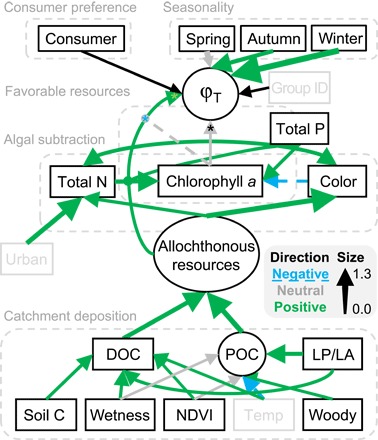
Modeled network of factors influencing terrestrial resource use (ϕT) by aquatic consumers across 147 lakes.Arrows point at modeled variables, with mean effects of one variable on another proportional to standardized effect size (see legend). Lines ending in circles are interactions. The asterisk symbol (*) indicates random variation among consumers, with colors showing direction of significant effects. Black lines are intercepts with no “effect direction,” ellipses are unobserved (that is, latent) variables, and gray boxes are covariates included to explain the connections between modeled variables and predictors of interest better. Five mechanisms explaining variation in ϕT are associated with broken boxes. NDVI, vegetation density; temp, mean monthly temperature of warmest quarter; woody, area of woody vegetation in catchment per meter shoreline; LP/LA, ratio of lake perimeter to lake area; group ID, research group that collected the data (such as to account for variation in sampling). Bayesian R2 for consumers with one (δ2H only), two (δ13C-δ15N), or three (δ13C-δ15N-δ2H) observed isotopes were 0.64, 0.98, and 0.99, respectively (fig. S5).